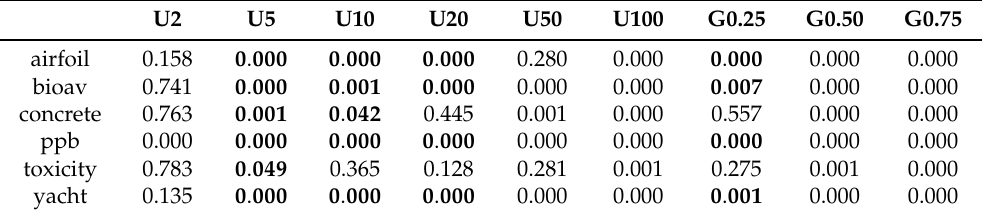
Table 5. p -values returned by the Wilcoxon rank-sum test under the alternative hypothesis that the median errors on the test set obtained from classical GSGP are equal with respect to the errors obtained with the methods introduced in this paper. Highlighted in bold, the p -values below 0.05 where the direction of the difference shows an improvement with respect to standard